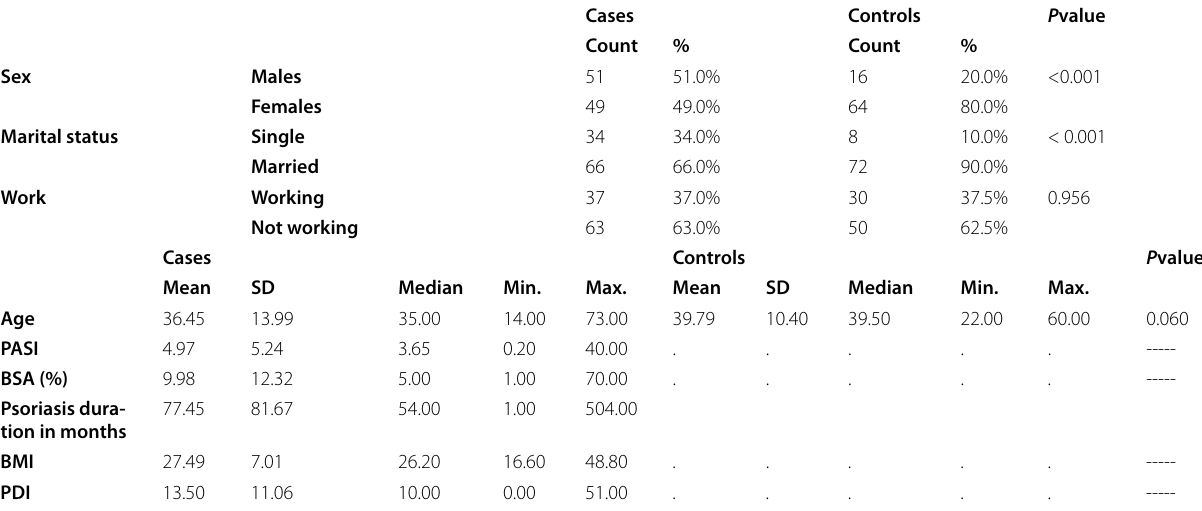
Table 1 Demographic data of cases and controls and clinical data of